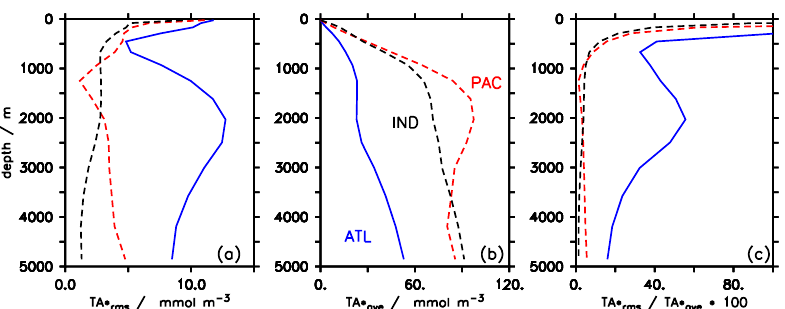
Figure 8. Basin-average vertical profiles of TA ∗ RMSE (a) , TA ∗ (b) and the percent ratio of the two (c) . Blue solid: Atlantic Ocean. Red dashed: Pacific Ocean. Black dashed: Indian Ocean. Table 3. Volume-weighted RMSEs for TA 0 and TA ∗ estimates based on seasonally unbiased TA 0 algorithm (all months) and winter- and summer-biased algorithms respectively. Column “surface” refers to the skill of the respective algorithm to reproduce the surface (upper 100m) alkalinity of the model. Column TA 0 gives RMSEs of subsurface preformed TA as compared with TA 0 from the explicit tracer. Column TA ∗ gives the RMSE of computed TA ∗ compared with TA ∗ from the explicit tracer. Global algorithms are also evaluated concerning their skills on regional scales.